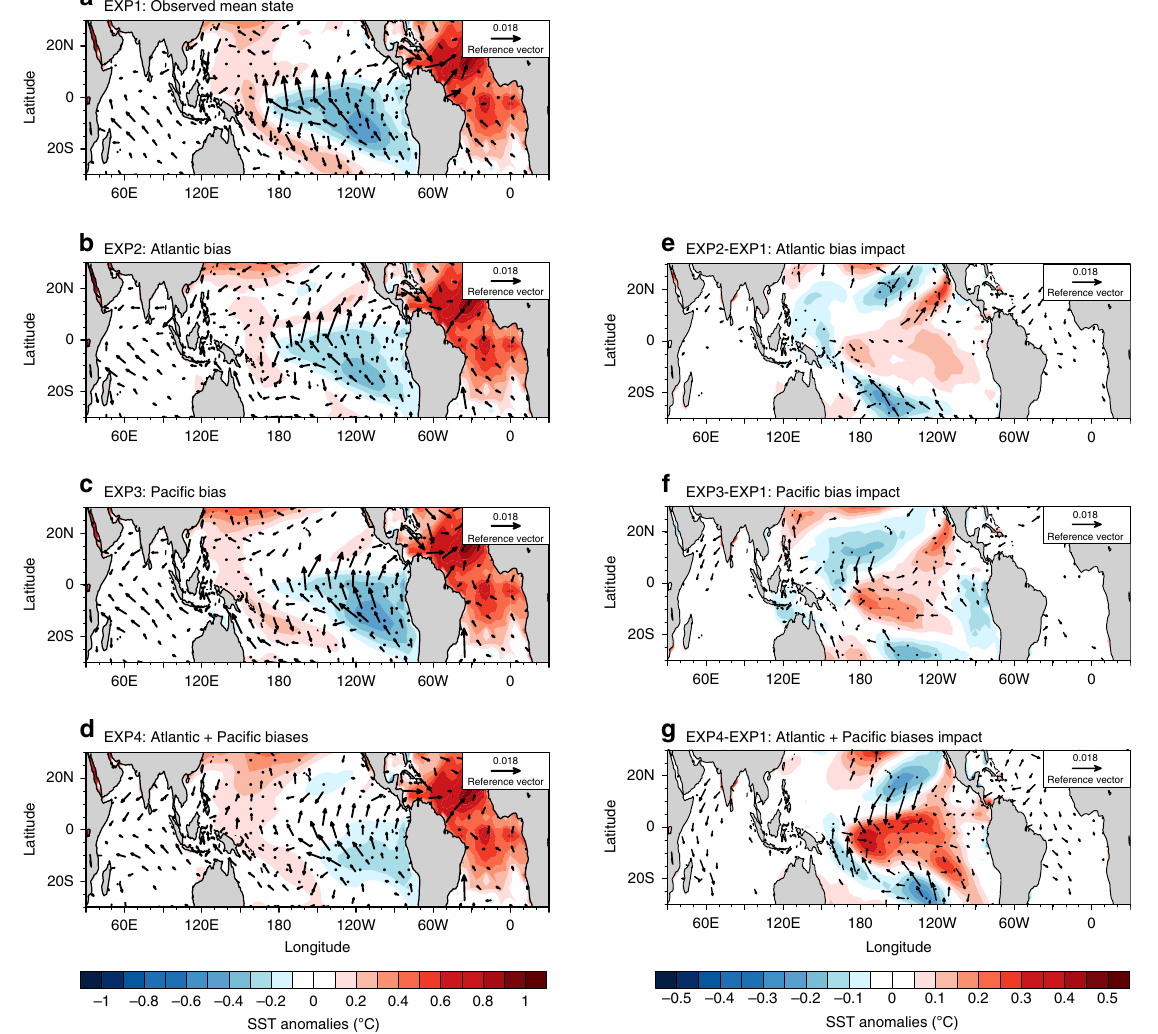
Fig. 1 Sea surface temperature and surface wind stress response. a Simulated sea surface temperature (SST) (shading; °C) and wind stress (vectors; N m − 2 ) response in the partially coupled (PARCP) simulations to the Atlantic warming forcing under the observed SST mean state (experiment 1, EXP1). b – d As in ( a ), but with additional CMIP5 Atlantic mean state bias (experiment 2, EXP2), Paci fi c bias (experiment 3, EXP3) and the combined Atlantic/ Paci fi c bias in the SST background (experiment 4, EXP4), respectively. e – g The response differences between ( b ) and ( a ), ( c ) and ( a ), and ( d ) and ( a ), respectively. Stippling indicates the statistical signi fi cant at the 90% con fi dence level for SST. Only the signi fi cant wind stress (zonal or meridional signi fi cant at the 90% con fi dence level) is shown in the